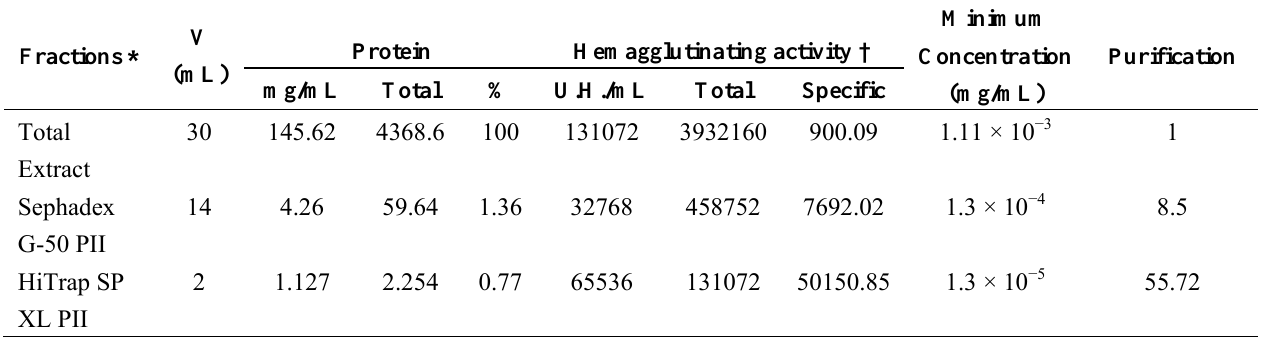
Table 1. Overall protein recovery and haemagglutinating activity of Dioclea wilsonii seeds at various stages of